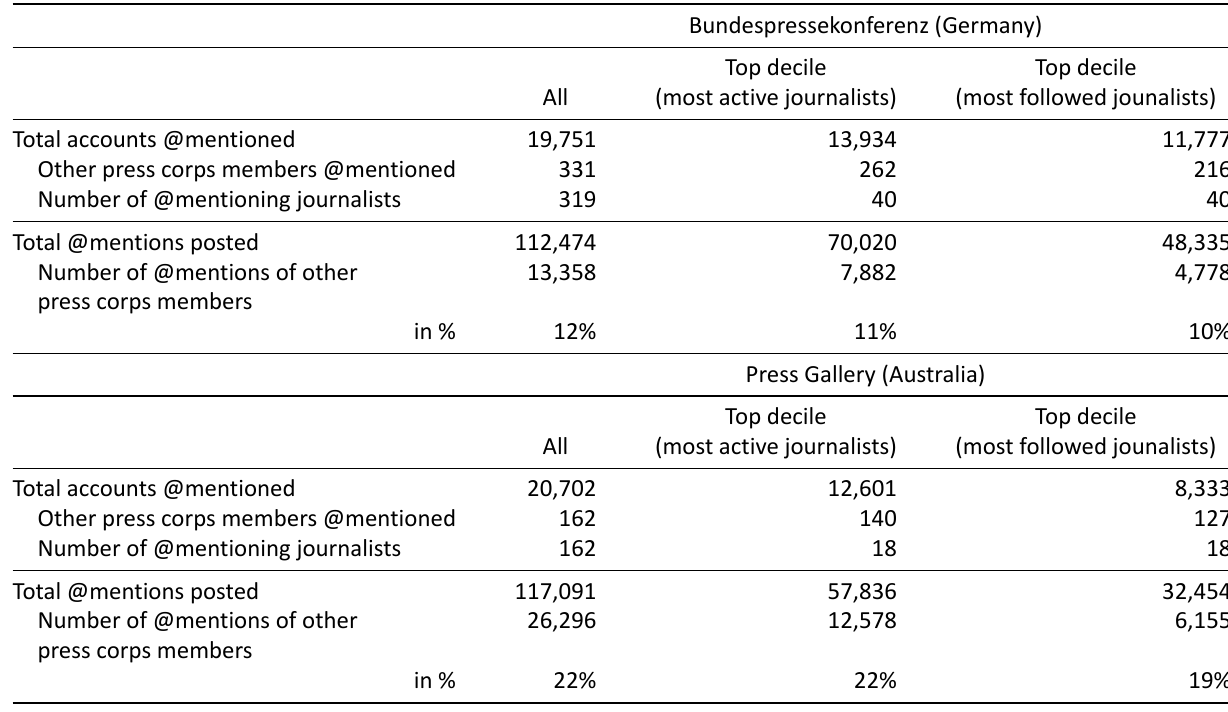
Table 4. Interaction metrics (@mentions only) for press corps journalists (2017).